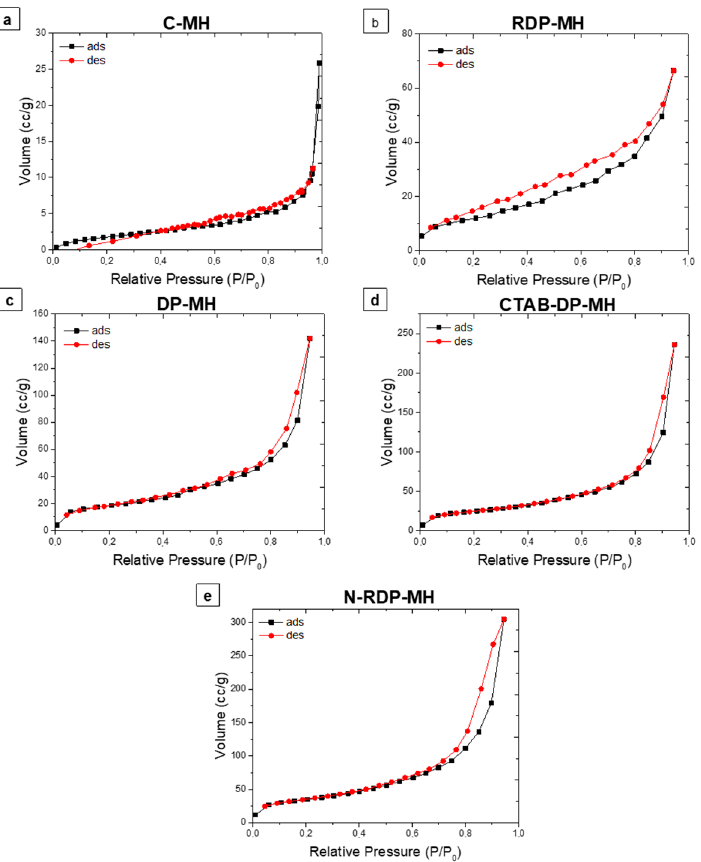
Figure 5. Isothermal physisorption curves of ( a ) C-MH, ( b ) RDP-MH, ( c ) DP-MH, ( d ) CTAB-DP-MH, ( e ) N-DP-MH.